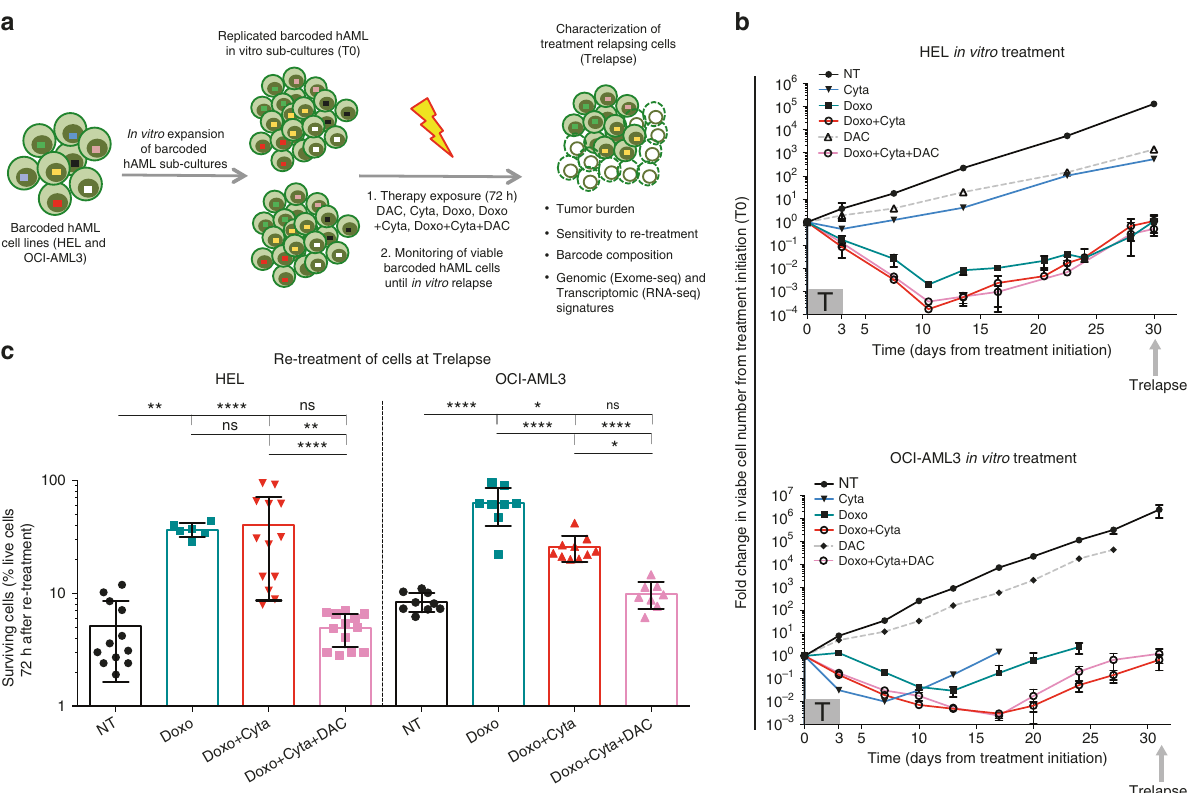
Fig. 1 Chemotherapy + Decitabine combination prevents chemoresistance in hAML cells. a Schematic diagram of the experimental system used. T0 indicates the time of treatment initiation and Trelapse is de fi ned as the post-therapy time point when re-grown hAML reached equivalent numbers as T0. NT – no treatment; DAC – decitabine (0.1 μ M); Doxo – doxorubicin (1.8 μ M); Cyta – cytarabine (6 μ M). b Total number of viable HEL and OCI-AML3 barcoded cells between T0 and Trelapse, de fi ned as a fold variation of cell number at each measured time point relatively to T0 ( n = 3 for NT and DAC, n = 5 for Cyta and Doxo, n = 8 for Doxo + Cyta and Doxo + Cyta + DAC, independent replicates). T box indicates the period of therapy exposure. c Frequency of viable Trelapse HEL and OCI-AML3 barcoded cells (NT: n = 12/9, Doxo: n = 6/8, Doxo + Cyta: 13/10 and Doxo + Cyta + DAC: 13/8, independent replicates in HEL / OCI-AML3 respectively) after re-exposure to Doxo + Cyta for 72h. Concerning panels b and c displayed graphs show mean±s.d.; P values were determined by one-way ANOVA test. ns – not signi fi cant, * P <0.05; ** P <0.01; *** P <0.001; **** P <0.0001. Source data are provided as a Source Data fi